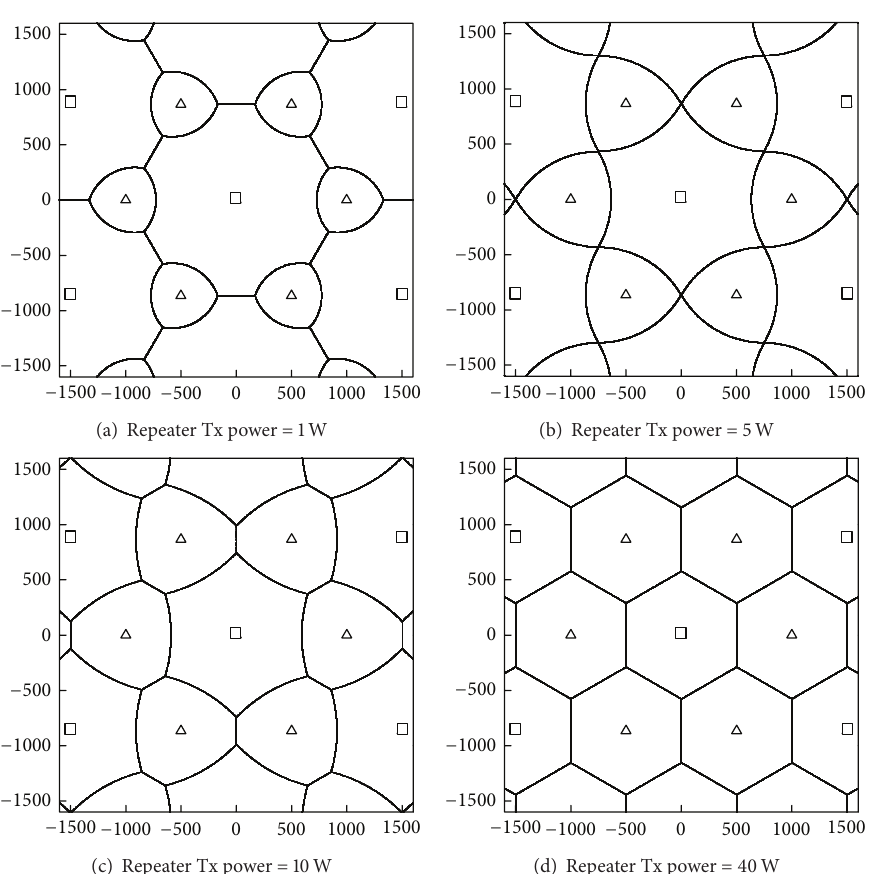
Figure5:Coverageboundariesofbasestationsandrepeaterswithdifferentrepeaterpowerlevels.Squaresandtrianglesrepresentbasestations and repeaters, respectively. Units of 𝑥 - and 𝑦 -axes are in meters.